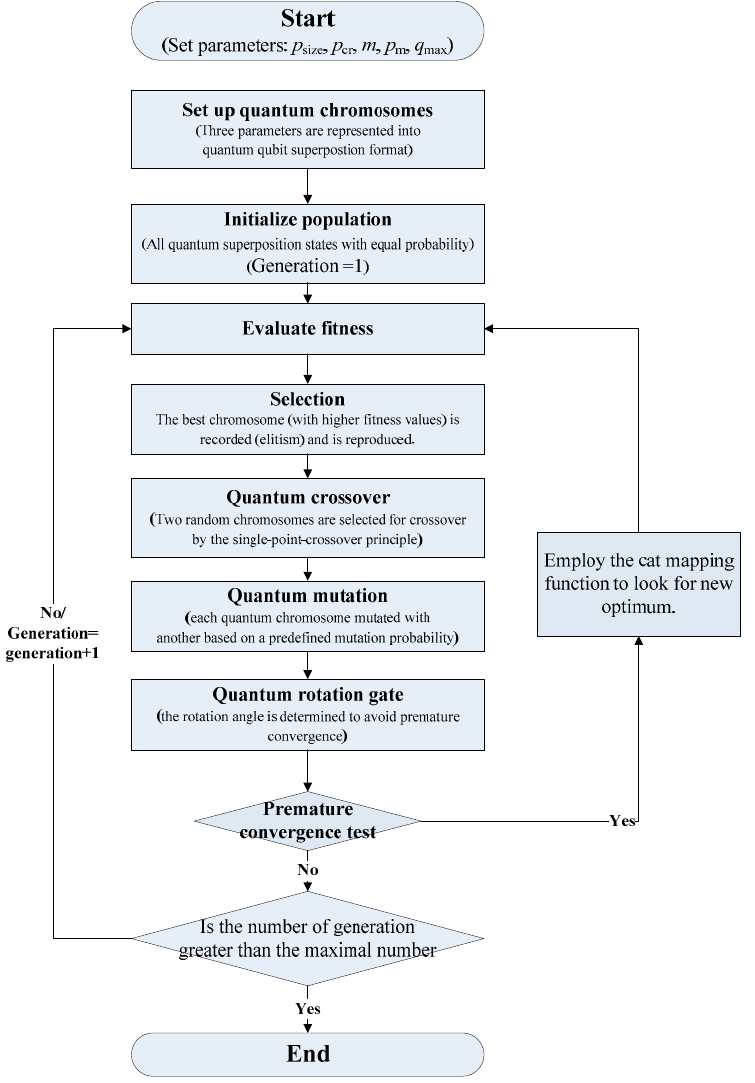
Figure 1. Quantum genetic algorithm flowchart.